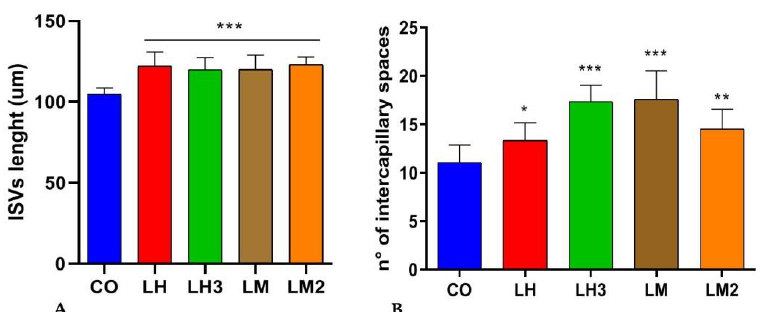
Figure 4. The graphs represent the mean values obtained for ISV length ( A ) and the average num- bers of intercapillary spaces in control and treated embryos ( B ). Data are representative of two rep- licates, and shown as the mean ± standard deviation; *** p < 0.001 vs. control group; ** p < 0.005 vs. control group; * p < 0.05 vs. control group; n = 15 from two independent experiments.